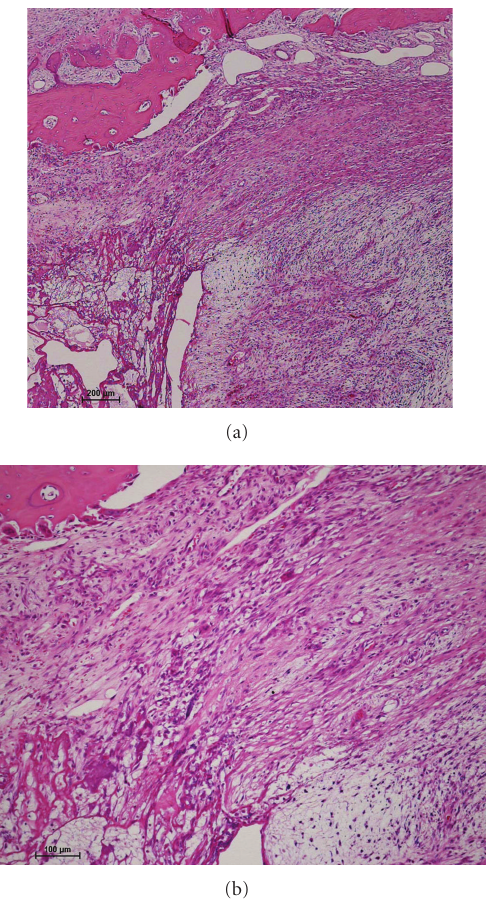
Figure 5: Hematoxylin and eosin stain of metastatic lesion of clavicle (a) × 40 and (b) × 100. The histological grade was also determined as grade